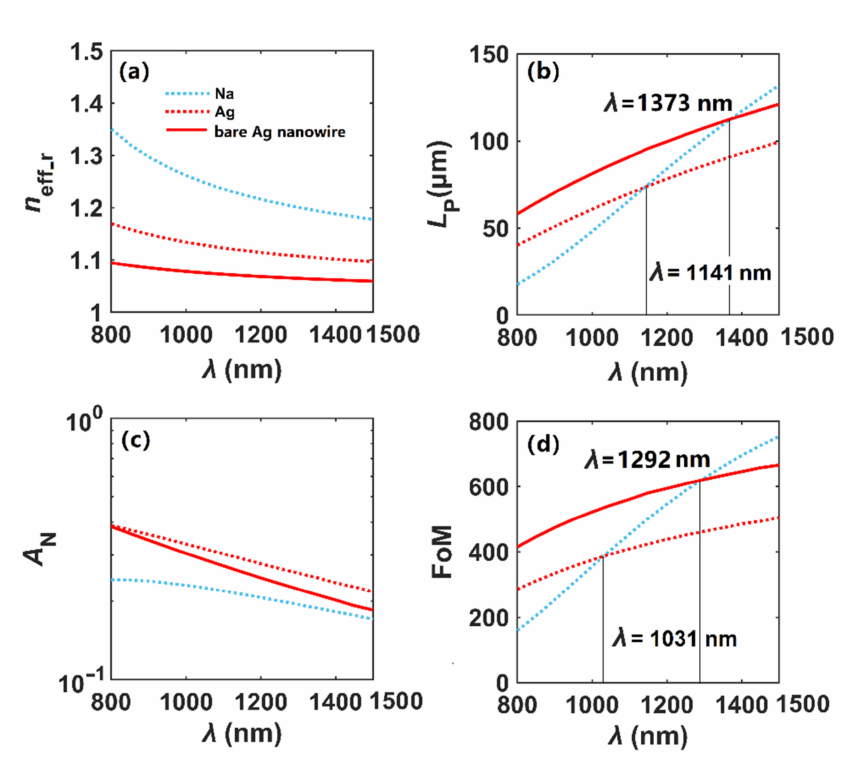
Figure 5. Modal properties of SiO 2 -coated Na and Ag nanowires. ( a ) n eff_r , ( b ) L P , ( c ) A N , ( d )